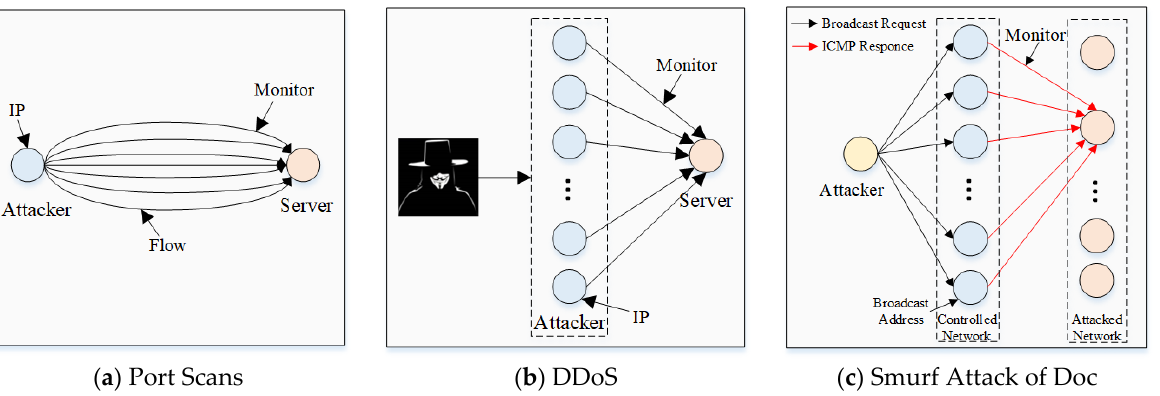
Figure 2. Interaction patterns of three common attacks . ( a ) Description of the interaction pattern of Port Scans Attack. ( b ) Description of the interaction pattern of DDoS. ( c ) Description of the interaction pattern of Smurf Attack.